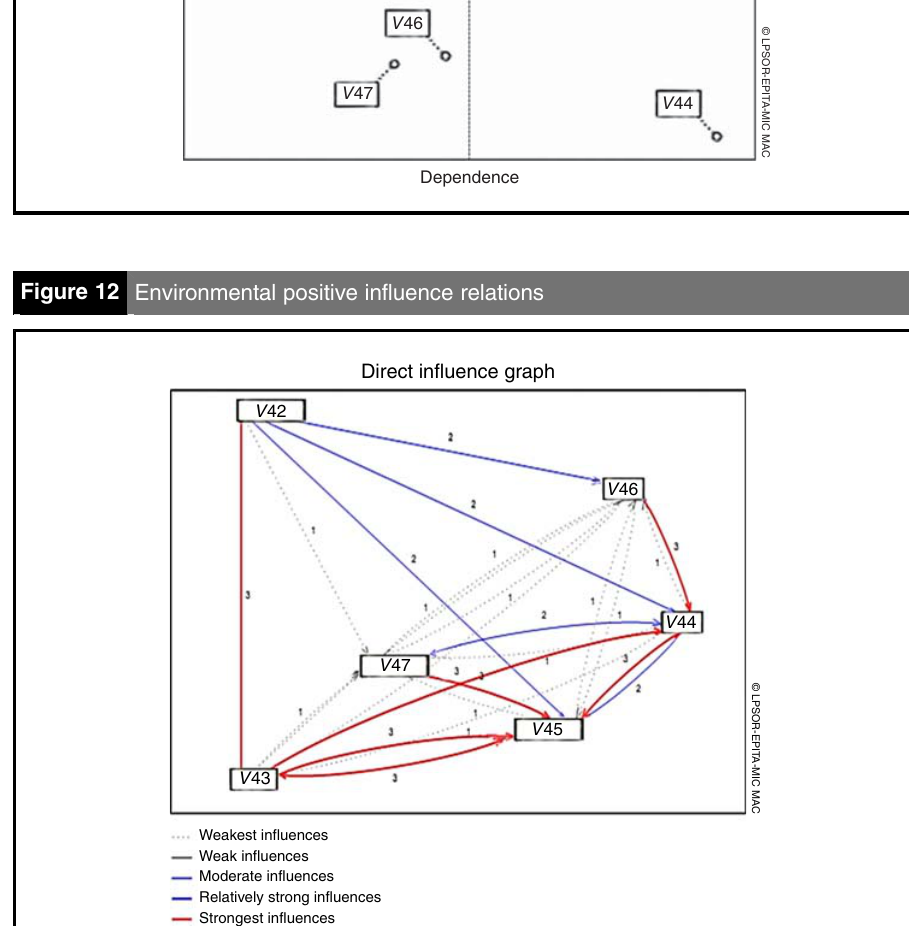
Figure 12 Environmental positive influence